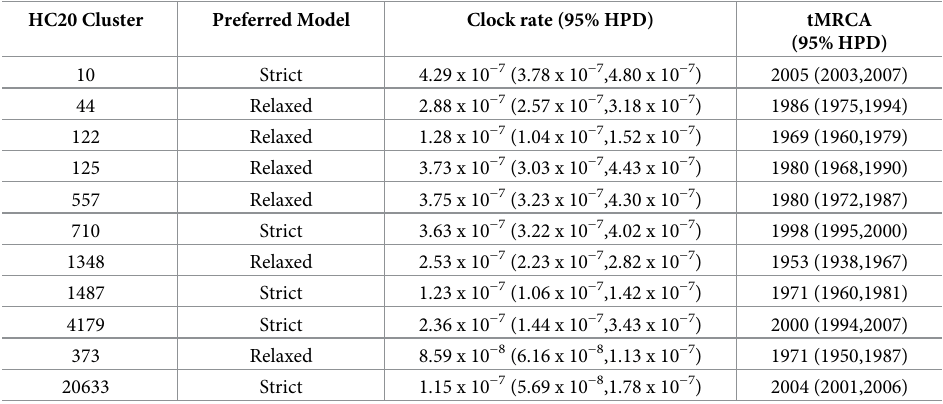
NOTE: Data are as in Table 2, except that the HC20_5519 and HC20_39803 were excluded because they did not possess statistically significant evidence for temporal signals. Furthermore, only genomes were included with metadata for calendar year or isolation and which were not outliers in an analysis with TempEst [38]. Marginal likelihoods are abbreviated as Contemp Strict: strict clock with isochronous dates; Contemp Relaxed: relaxed clock with isochronous dates; Strict: strict molecular clock with heterochronous dates; Relaxed: relaxed molecular clock with heterochronous dates. BF1 (Log Bayes Factor 1) is Strict vs Contemp Strict. BF2 is Relaxed vs Contemp Relaxed. BF3 is Relaxed vs Strict. https://doi.org/10.1371/journal.pgen.1009820.t004 separate analysis, we also calculated a Maximum Clade Credibility (MCC) tree from HC20_373 plus an outgroup genome (Fig 6). That tree estimated the tMRCA of HC20_373 as 1983, and a branching date from the outgroup genome of 1890 (95% HPD 1858–1927) (Fig 6; EnteroBase genome barcodes in S3 Fig). Thus, the tMRCA of HC20_373 is approximately 10– 20 years more recent than the date of isolation of CDC 60–6516, the ancestor of ATCC14028s, and 80–90 years after HC20_373 separated from other clusters in HC50_147. These estimates Table 5. Clock rate and tMRCA of eleven HC20 clusters.